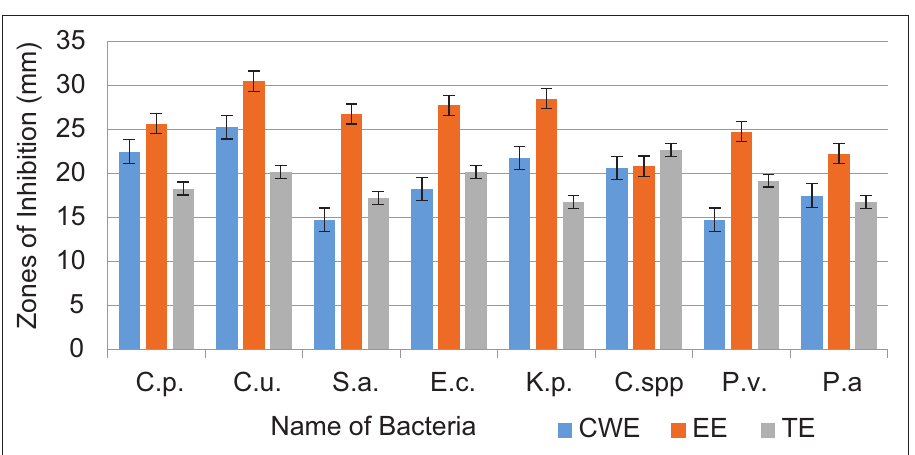
Figure-1: Moringa oleifera extracts and tetracycline antibiotic effect on some pyogenic bacteria. CWE=Cold water extract, EE=Ethanol extract, TE=Tetracycline, C.p.= Corynebacterium pseudotuberculosis , C . u . = Corynebacterium ulcerans , S.a= Staphylococcus aureus , E.c.= Escherichia coli , K.p. =Klebsiella pneumoniae , C.spp.= Citrobacter spp., P.v.= Proteus vulgaris and, P.a= Pseudomonas aeruginosa